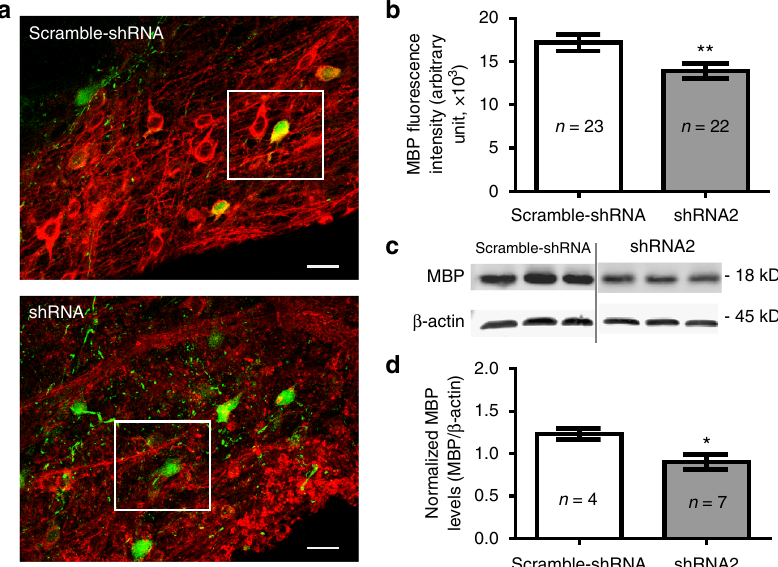
Fig. 9 Knockdown of Na v 1.2 channels in pre-OLs impacts the myelination. a Confocal images of immunostaining for MBP in the auditory brainstem following the viral injection of vectors encoding scrambled shRNA ( upper ) and shRNA2 for Na v 1.2 ( lower ). Scale bar , 20 μ m. b Summary of the fl uorescence intensity of MBP ( red ), which was measured in a 50 μ m × 50 μ m area surrounding CNPase-GFP+ cells within ( white box ). c Representative western blots probed for MBP and β -actin levels from three individual brainstem samples in each groups injected with scrambled shRNA ( upper ) and shRNA2. d Summary of normalized MBP levels. Detected western blot intensities for MBP were normalized to corresponding β -actin band intensities. All data represent the mean ± s.e.m.; * P < 0.05, ** P <